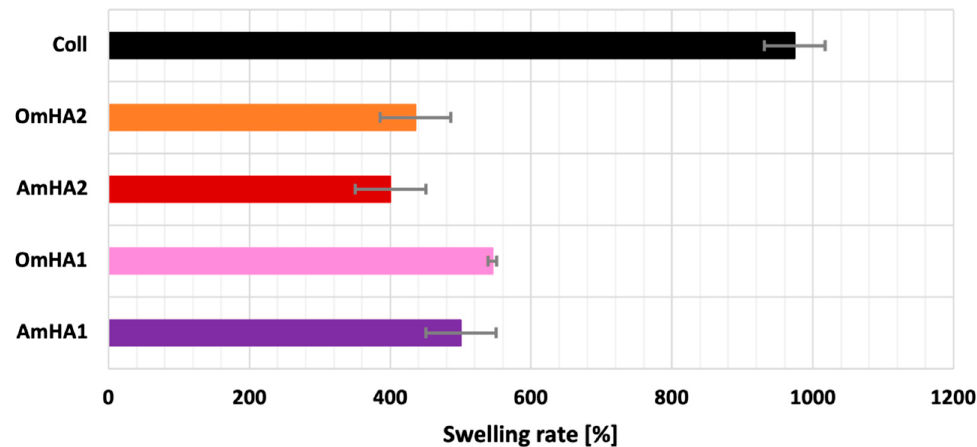
Figure 7. Results of swelling test for the obtained composites and collagen type I.